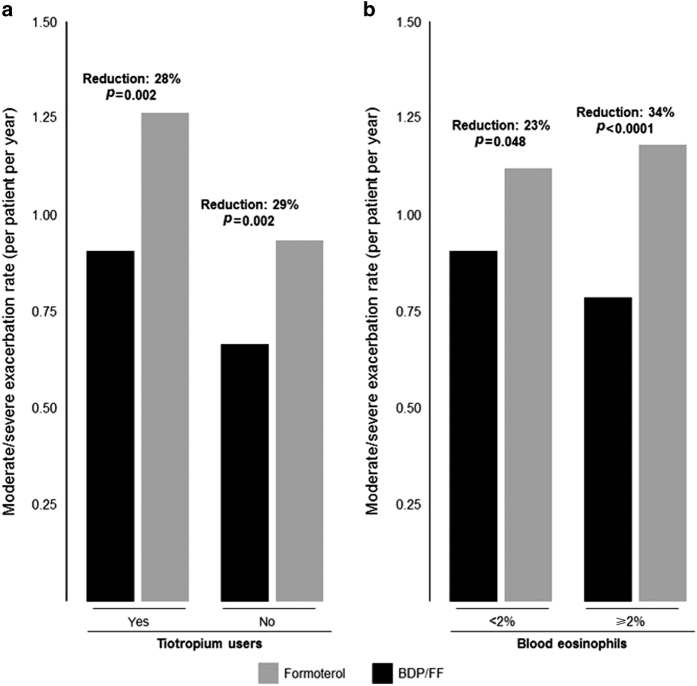
COPD exacerbations during the FORWARD study in patients stratified by different baseline characteristics. (a) Use of tiotropium before study entry; data from Wedzicha et al.
28 (b) Percentage count of baseline blood eosinophils; data on file. BDP/FF, beclometasone dipropionate/formoterol.